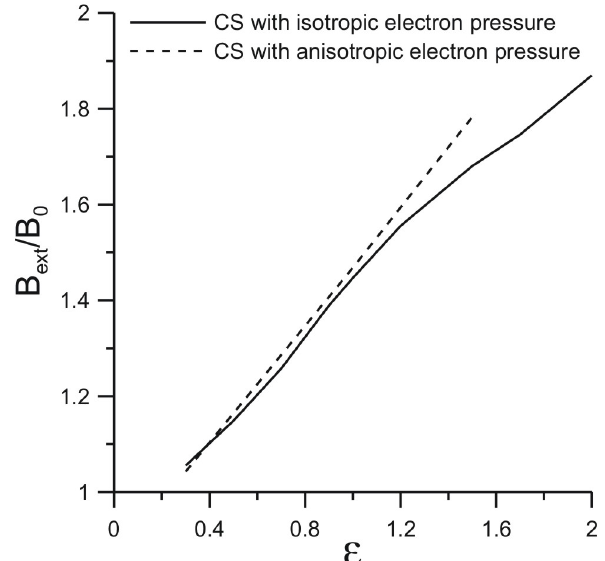
Fig. 3. The model dependence between embedding ( B ext (cid:14) B 0 mag- netic field ratio) and parameter ε (see text for details).